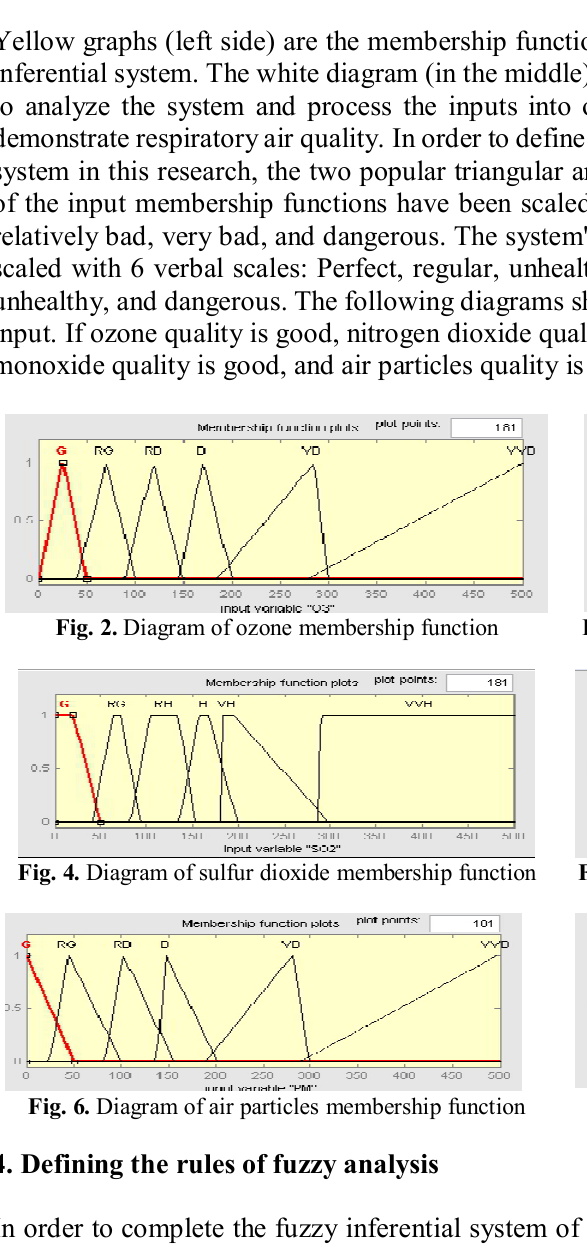
Fig 1. Diagram of fuzzy inference system of air quality